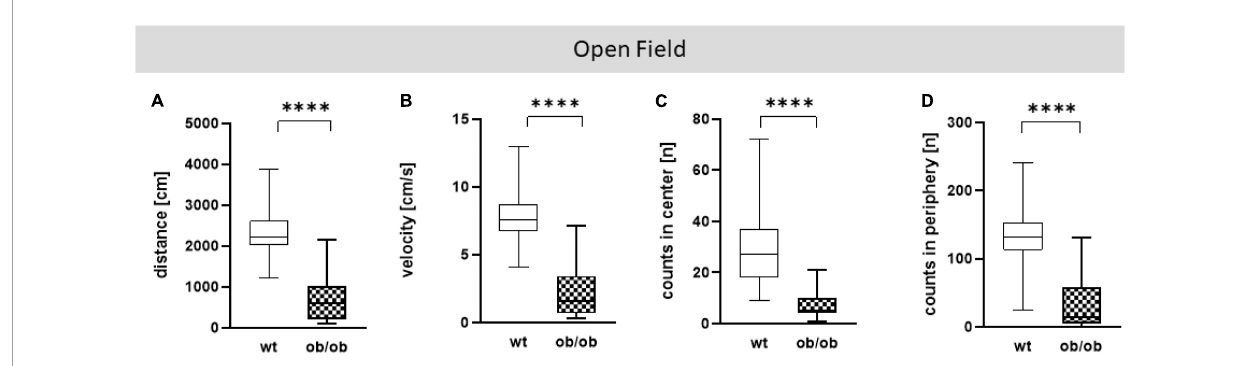
FIGURE3 Open Field (OF) test analysis. (A) Moved distance (cm), (B) mean velocity (cm/s), (C) number of visits (counts) in center (n), (D) number of visits (counts) in periphery (n). Analyses were done with the EthoVision software. The group size was as follows: n (wt) = 36 (A–D) , n (ob/ob) = 40 (A,B,D) and 39 (C) . Significance of differences between the groups were tested by unpaired Student’s t -test. Statistical significance was set at ∗∗∗∗ p < 0.0001.